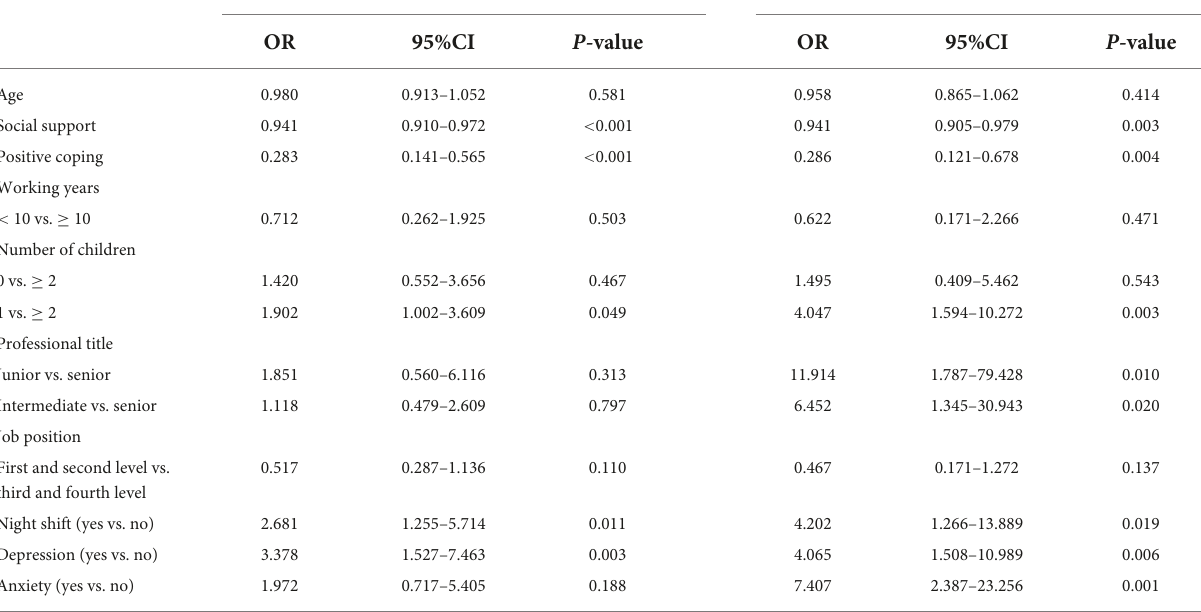
TABLE 2 Multinomial Logistic regression analysis of burnout among stay behind healthcare workers during COVID-19 pandemic (n = 434).